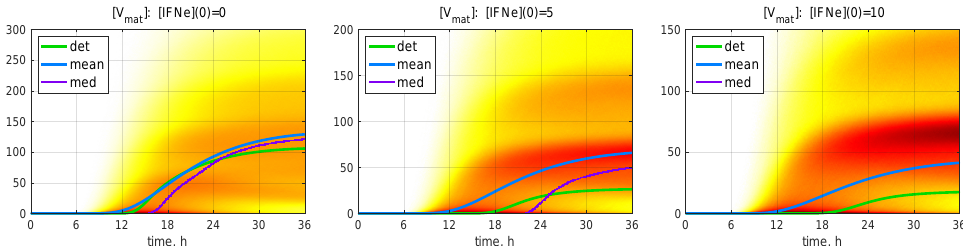
Figure 7. Probability density function (PDF) of stochastic realisations. Time-varying histograms for [V mat ] are computed for MOI = 6 and for different values of [ IFN e ]( 0 ) (indicated in the top of every plot). Furthermore, the deterministic solutions (det), mean values (mean), and medians (med) are plotted (colours for the lines are explained in the legend). A darker colour corresponds to a higher value of the histograms. Multi-hump patterns in the trajectory ensembles are present in the